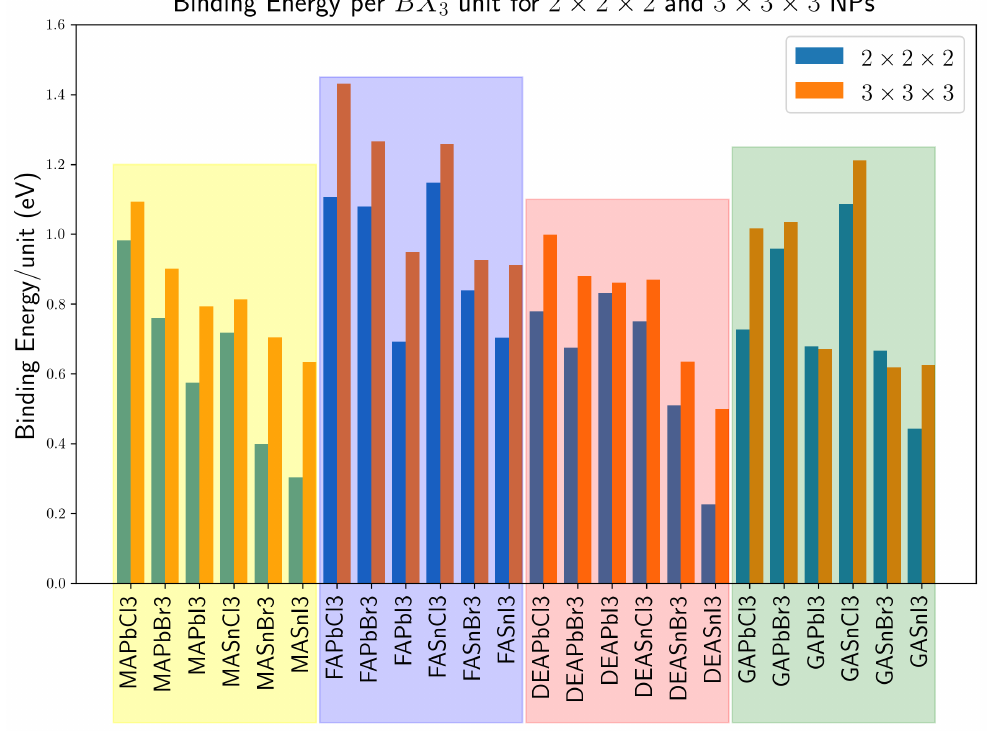
Figure 2. The binding energy per unit formula for all 2 × 2 × 2 and 3 × 3 × 3 nanoparticles